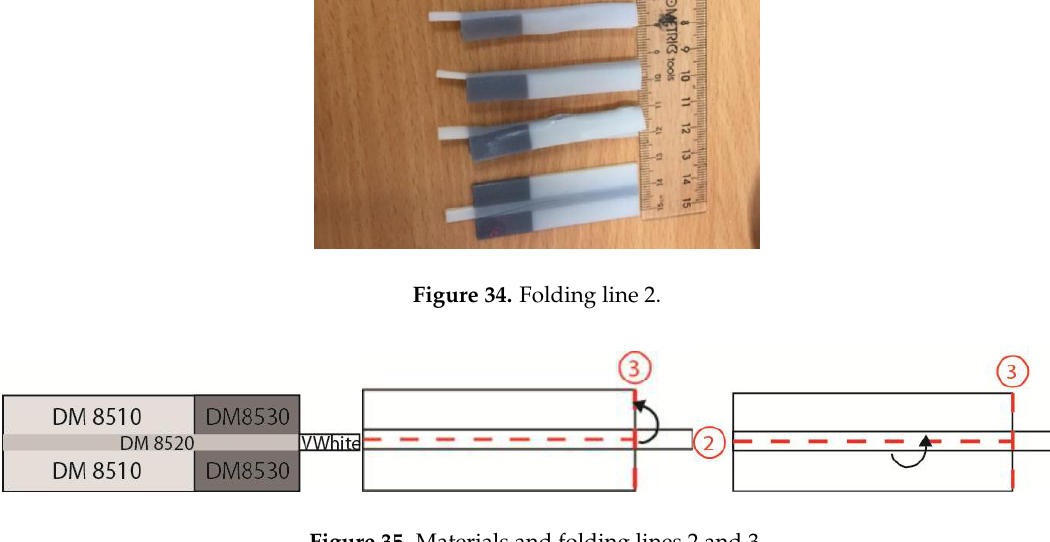
Figure 33. Folding line 3.